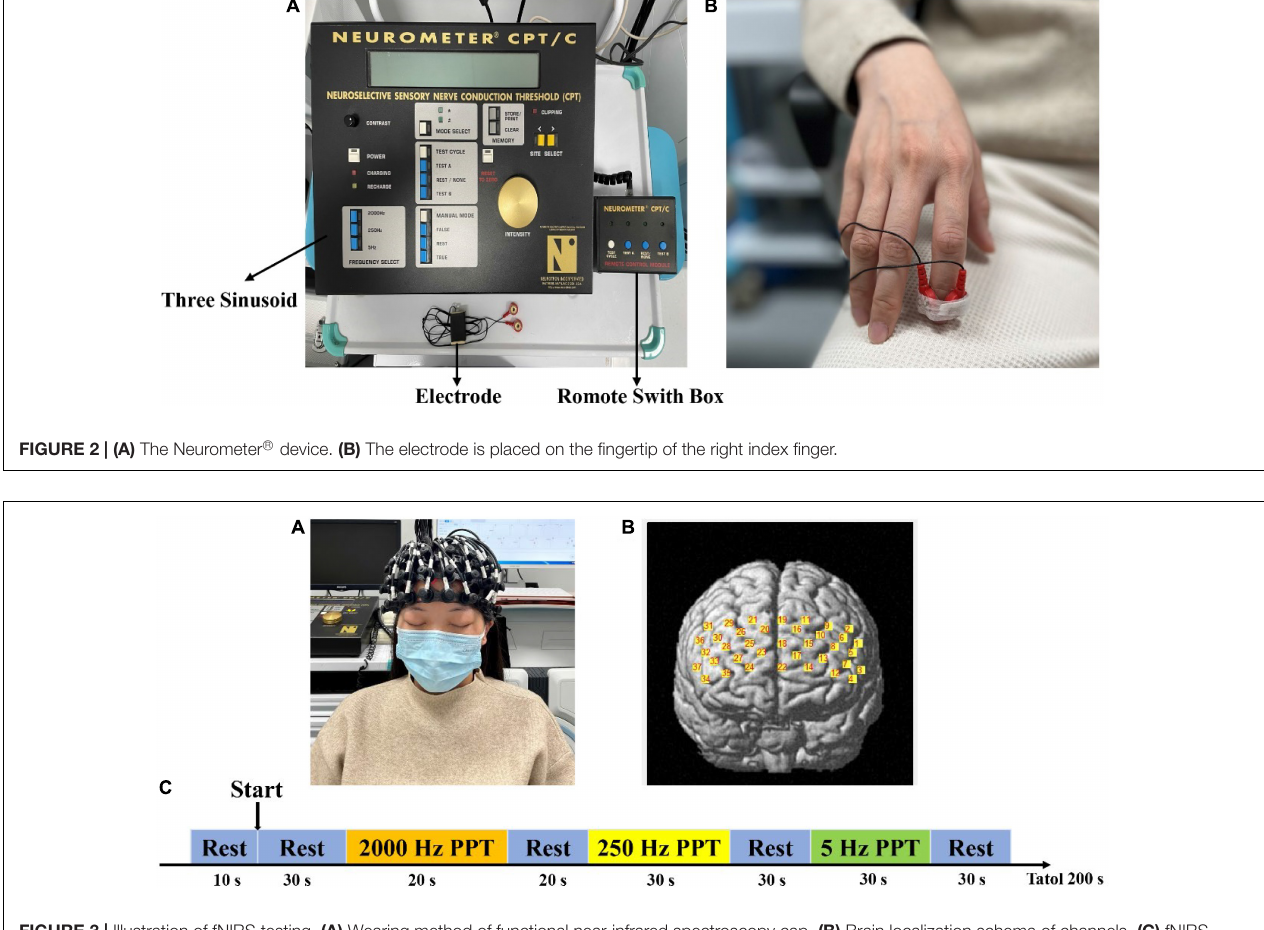
FIGURE 3 | Illustration of fNIRS testing. (A) Wearing method of functional near-infrared spectroscopy cap. (B) Brain localization schema of channels. (C) fNIRS testing procedure. PTT means pain tolerance